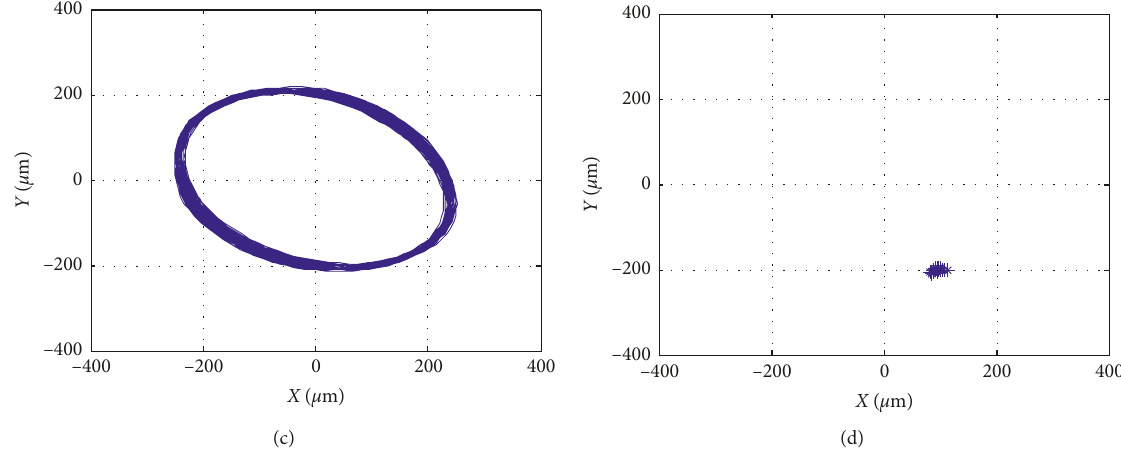
Figure 8: Normal state at 3000r/min. (a) Time-domain waveform. (b) Spectrum graph. (c) Axis orbit. (d) Poincare orbit.